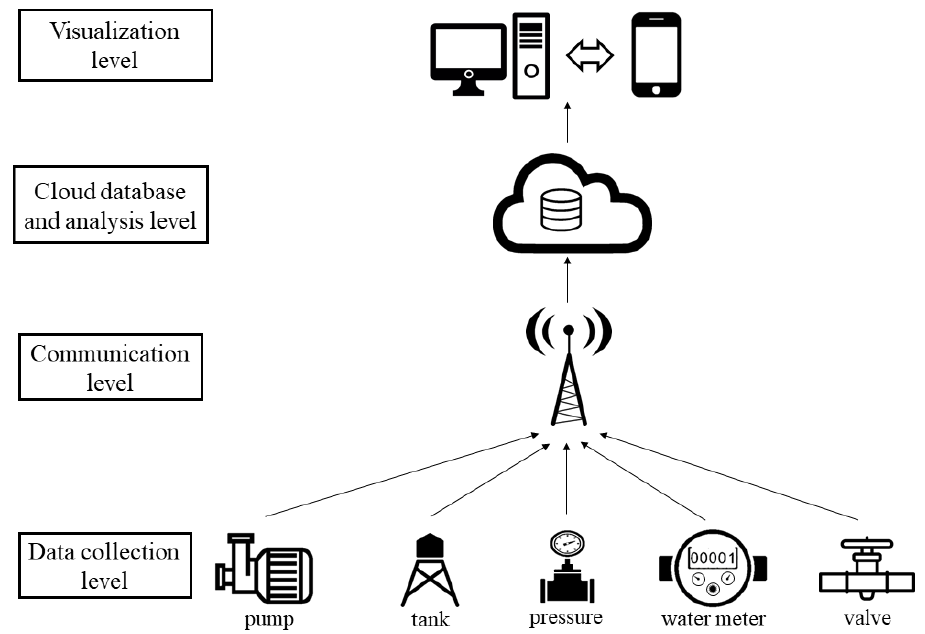
Figure 1. Typical low-power wide-area (LPWAN) network architecture for water supply systems.